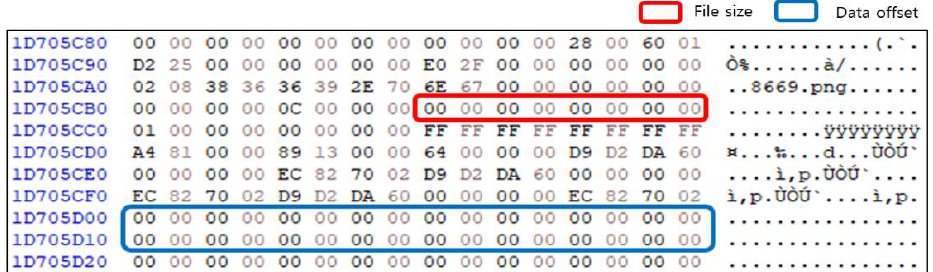
Figure 23. Record of deleted 8669.png file without file size and offset.